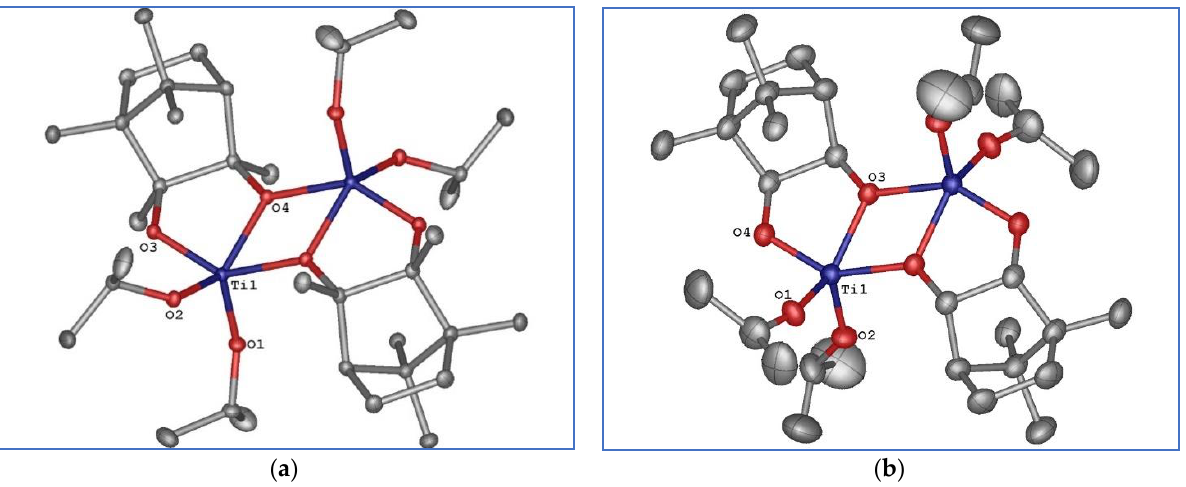
Figure 1. General view of the compounds 1 ( a ) and 2 ( b ) in representation of atoms via thermal ellipsoids at 30% probability level. Both molecules occupy the special positions, the inversion centers, as obtained by X-ray diffraction at 100 and 240 K. Hydrogen atoms are omitted for clarity. In both crystals, the complex occupies a special position, the inversion center, so only labels of symmetry-independent heteroatoms are given.